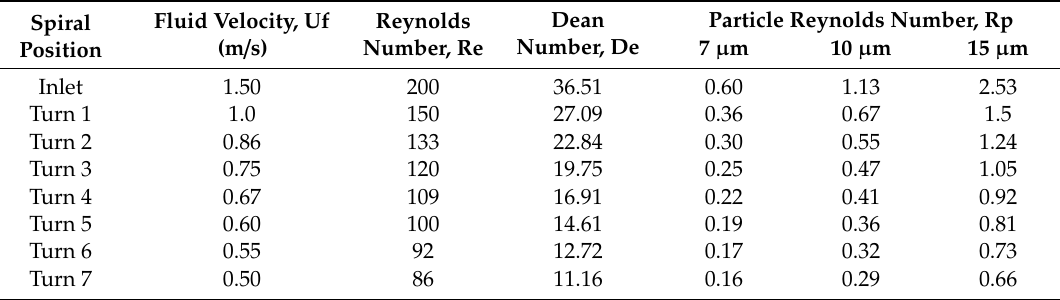
Table 2. Key dimensionless fluidic parameters at selected loci on the spiral, at a constant flow rate of 1.8 mL / min. With an expanding channel width, particle Reynolds number and fluid velocity will vary along the spiral